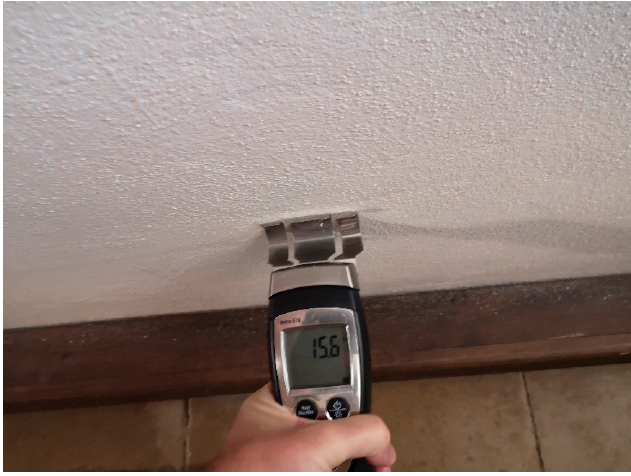
Figure 7. A picture representing the moisture rate of the structure.